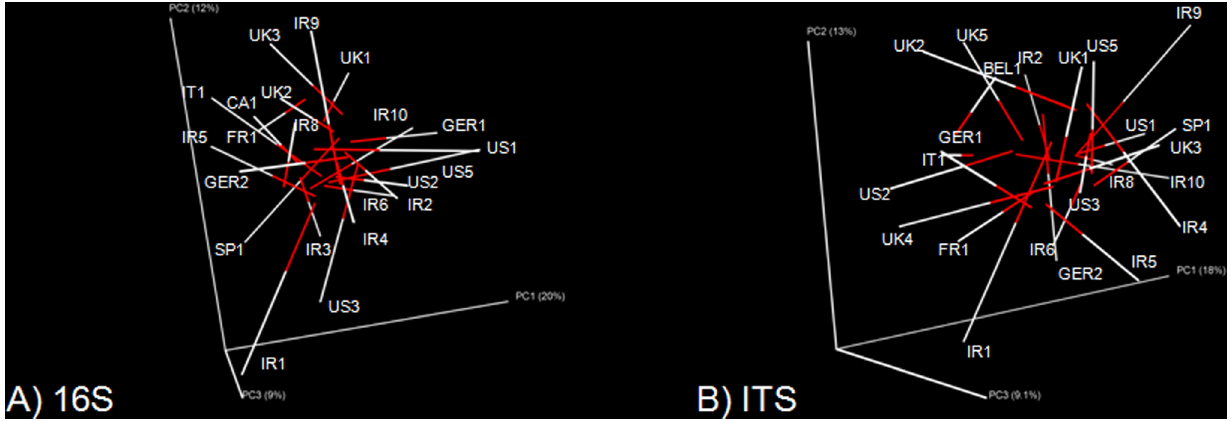
Figure 2. Procrustes imaging of unweighted UniFrac distance matrices highlight the diversity amongst the 16S bacterial component (A) and fungal component (B) of the different kefir samples. The two different sample types are linked with a bar (white represents grain flora; red represents milk flora). The direction of each axis is arbitrary.